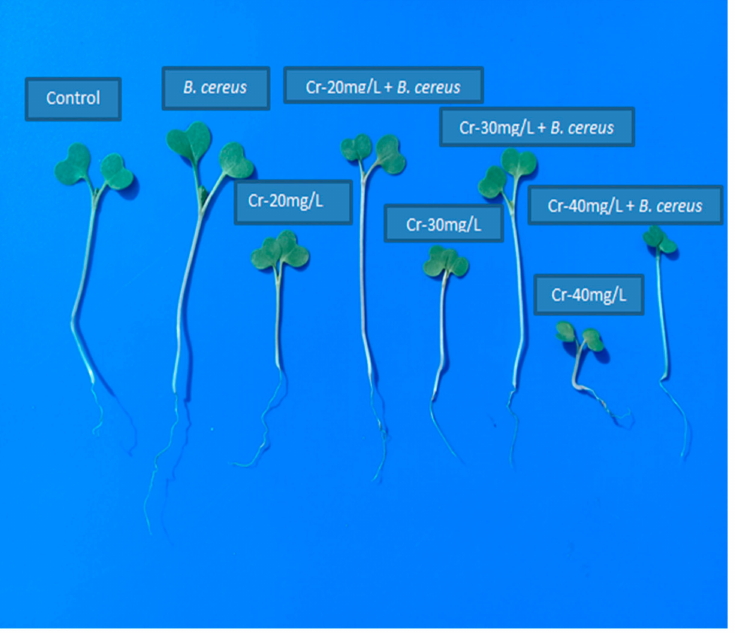
Figure 1. Effect of chromium stress and inoculation of B. cereus on germination of B. nigra. Where T0 = Control, T1 = B. cereus , T2 = Cr-20 mg/kg, T3 = Cr-20 mg/kg + B. cereus , T4 = Cr-30 mg/kg, T5 = Cr-30 mg/kg + B. cereus , T6 = Cr-40 mg/kg, T7 = Cr-40 mg/kg + B. cereus